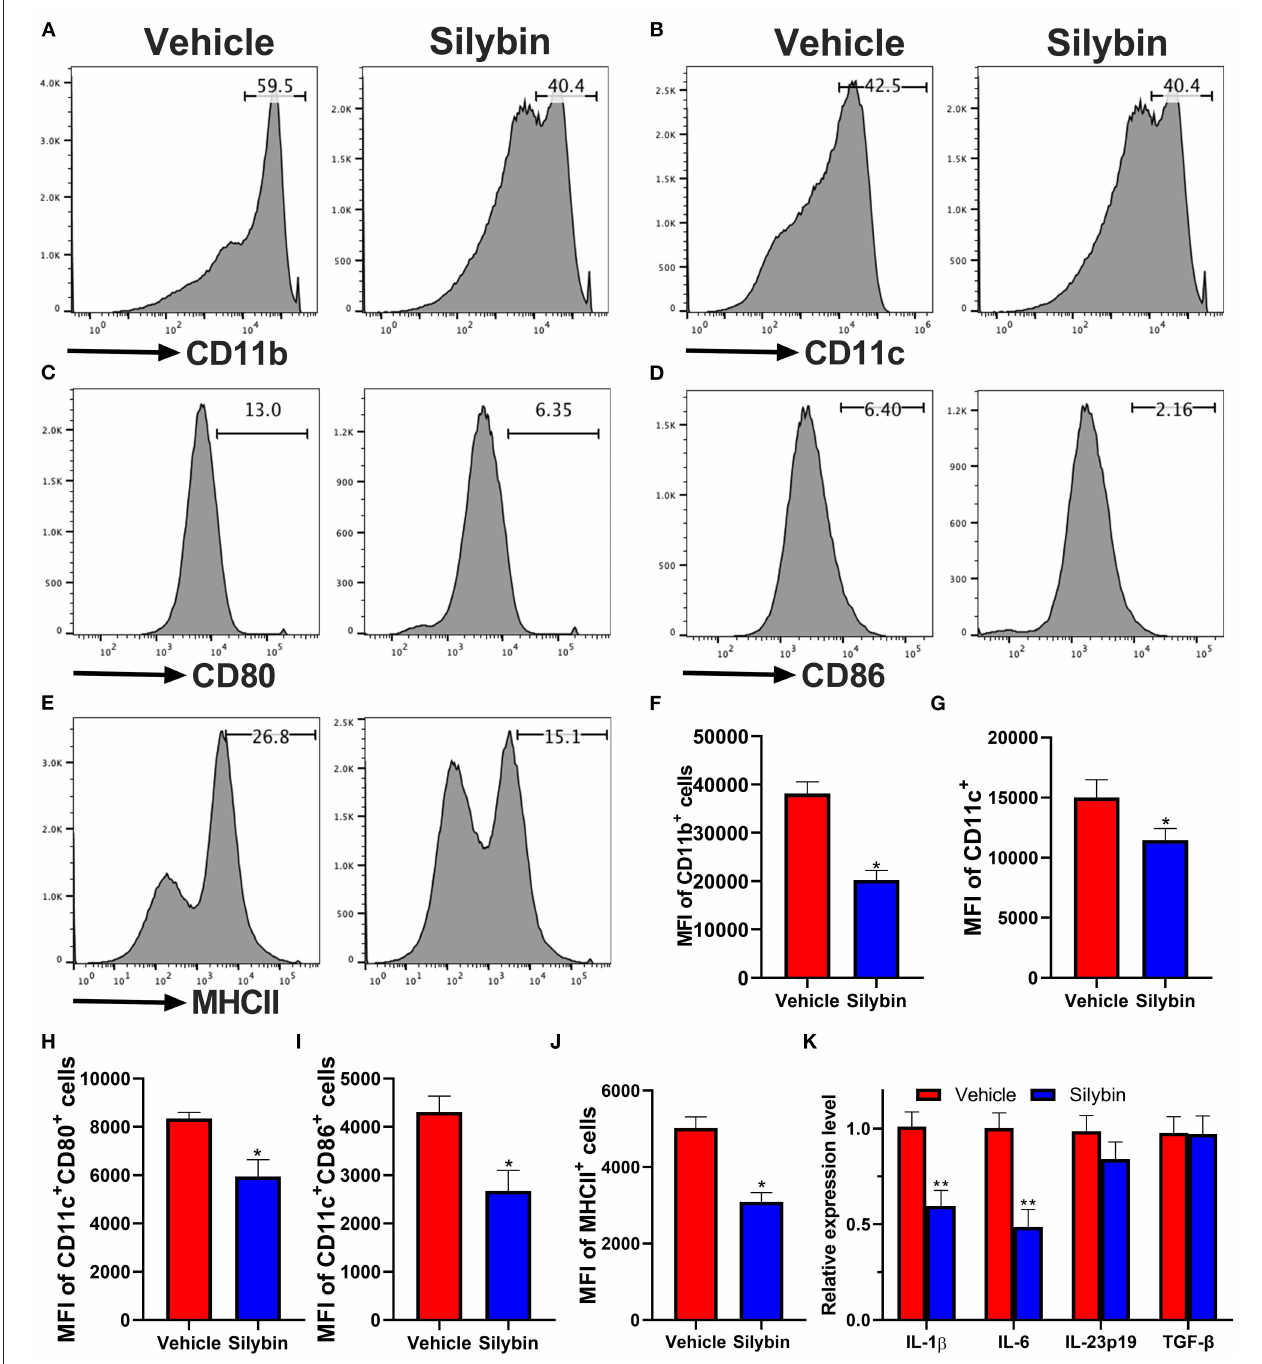
FIGURE 5 | Silybin inhibited the activation of bone marrow-derived dendritic cells (BM-DCs) in vitro . BM-DCs were generated and stimulated with 100 ng/ µ l of lipopolysaccharide (LPS), and simultaneously, silybin at a dose of 50 µ M was added into the culture medium. After 18h, expression of (A) CD11b, (B) CD11c, (C) CD80, (D) CD86, and (E) MHC II (the positive cells of CD80, CD86, and MHC II are gated below the CD11c-positive cells) was measured by flow cytometry following overnight incubation and treatment with or without silybin. (F–J) Percentages of each molecule were counted. (K) Figures (A–E) are representatives of three independent experiments. Statistical data are expressed as mean ± SD of three independent experiments. * p < 0.05 and ** p < 0.01 by Student’s t -test.